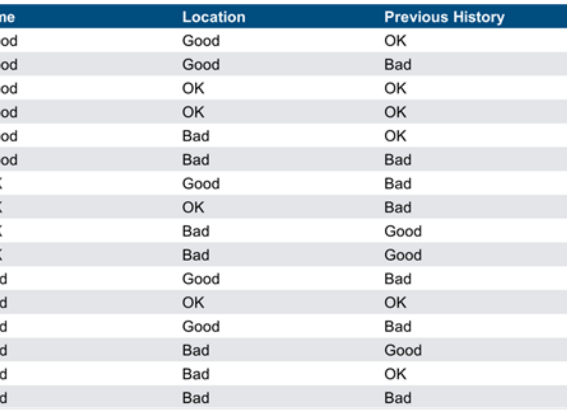
Table 10. Analysis for Yes Cases for